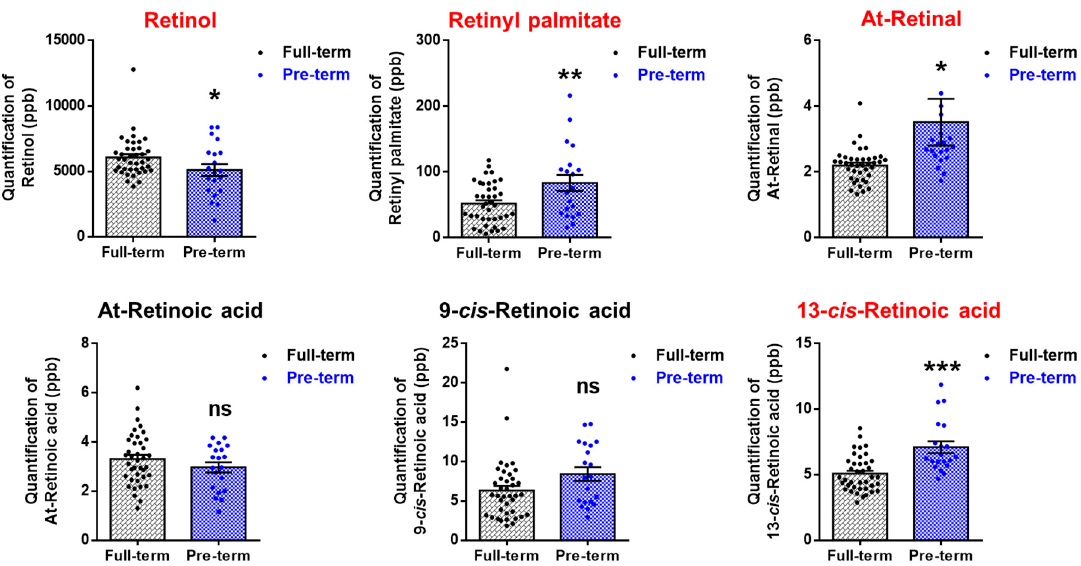
Figure 4. Retinoid metabolites showing changes in plasma of preterm birth using retinoid metabolite analysis (39 TB, 20 PTB). At: all trans. Student’s t- test, * p < 0.05, ** p < 0.01, *** p < 0.001, and ns = non-significant.